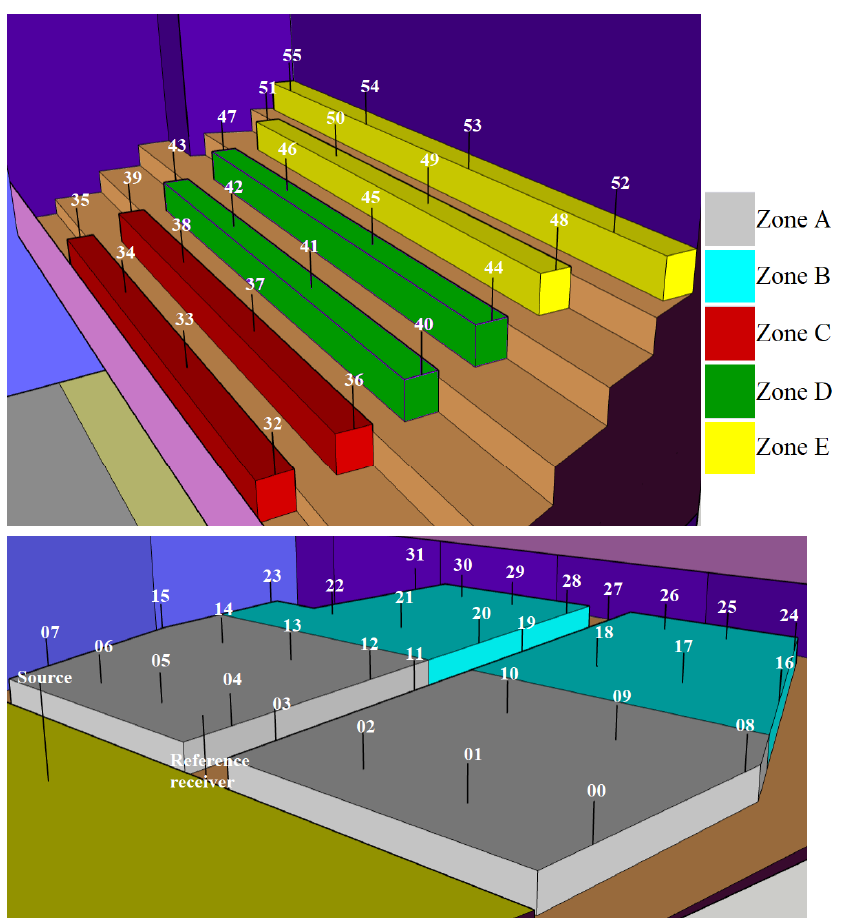
Figure 6. Position of sound source (situated on the stage), numerical receivers placed on the balcony ( top figure) and on the parterre ( bottom figure) and identification of the several receiver zones.